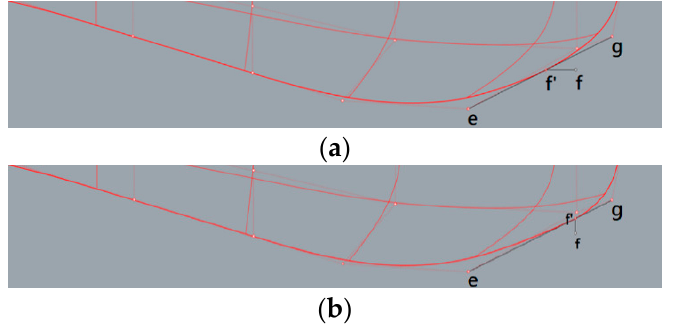
Figure 7. Front-edge fairing by moving control point f to control point f’. ( a ) B17.018h, ( b ) B17.018v. (Control point e and control point g are maintained in the original position).